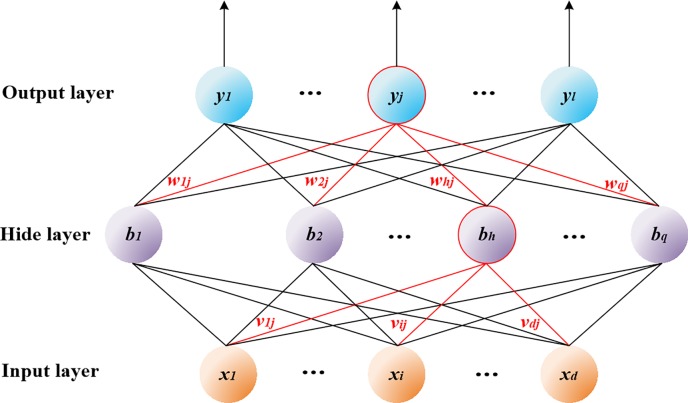
Structure diagram of BPNN structure diagram.